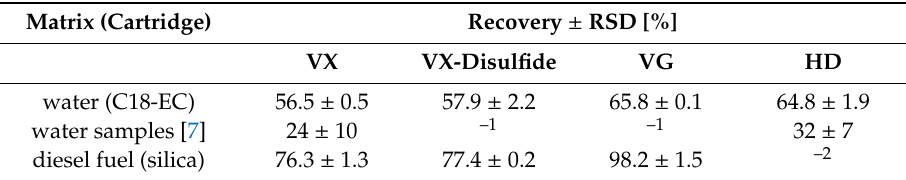
Figure 6. Chromatograms of the sample containing a strong hydrocarbon background from diesel fuel: TIC-scan of the raw sample ( top ), SIM-scan of the raw sample ( middle ) and SIM-scan after sample preparation with silica cartridge ( bottom ). Table 3. Recovery rates of chemical warfare agents from aqueous samples and strong hydrocarbon background containing organic